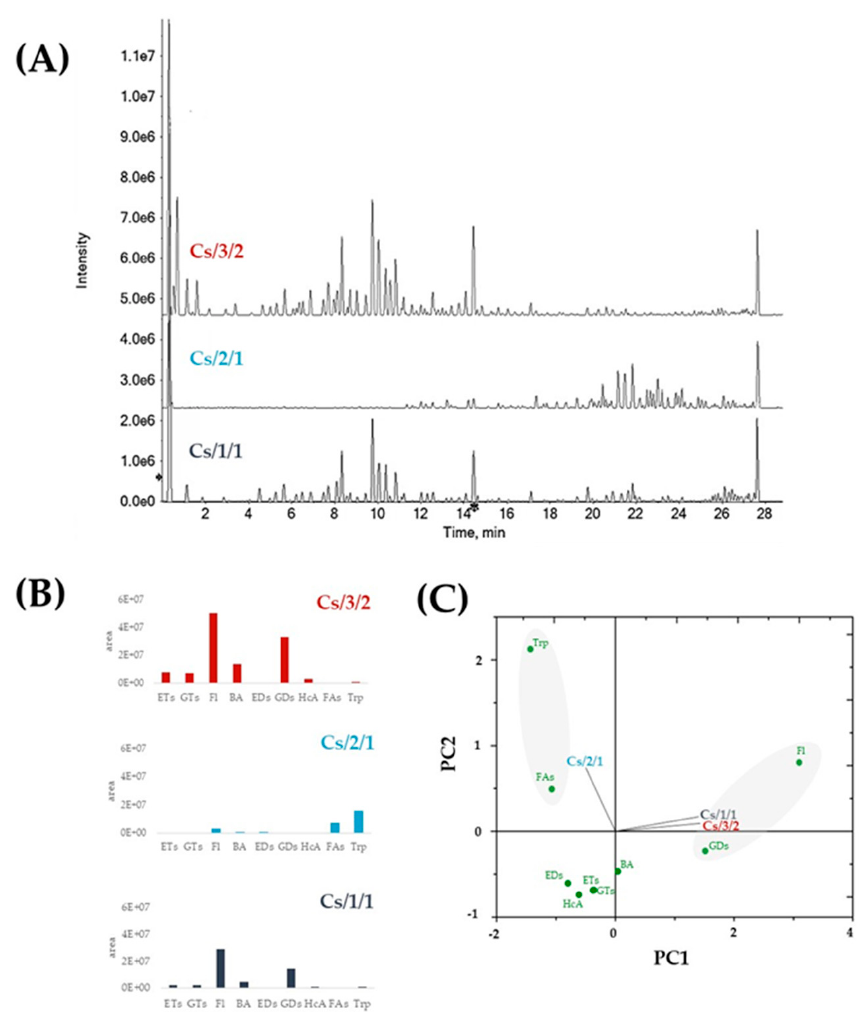
Figure 3. ( A ) Total ion current (TIC) chromatograms of Cs/1/1 extract, Cs/2/1 fraction, and Cs/3/2 fraction. ( B ) The relative content of each extract/fraction in derivatives of benzoic acid (BA), hydroxycinnamic acid (HcA), derivatives of gallic (GDs) and ellagic acid (EDs) as well as flavonoids (Fl), gallotannins (GTs), ellagitannins (ETs), fatty acids (FAs), and triterpenes (Trp), is shown. ( C ) Principal component analysis (PCA), based on different classes of identified compounds. PC1 % variance = 68.3; PC2 % variance = 31.3.